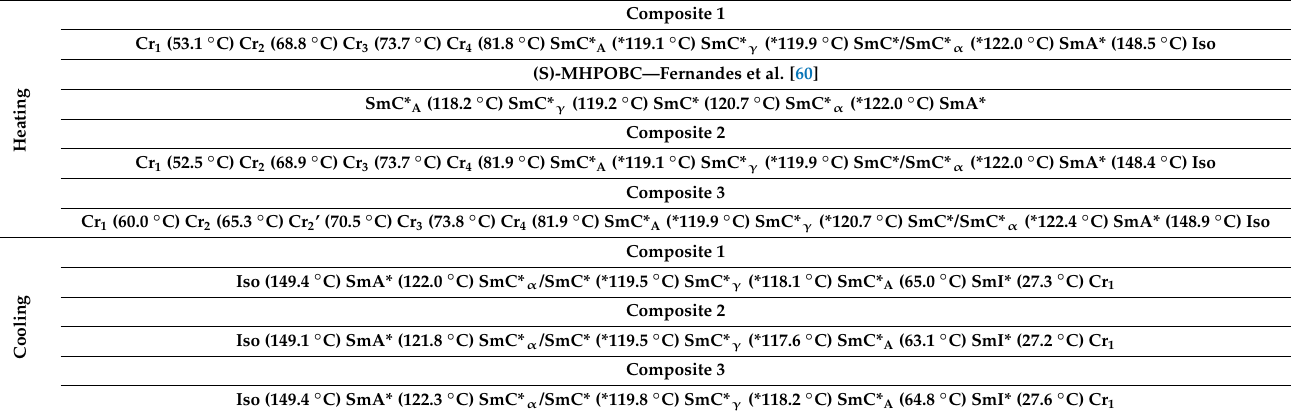
Table 1. Phase sequences during heating and cooling for Composites 1–3 obtained by texture observations and the DSC method. The asterisk next to temperature denotes the peak temperature T p , ∆ T = ± 0.1 ◦